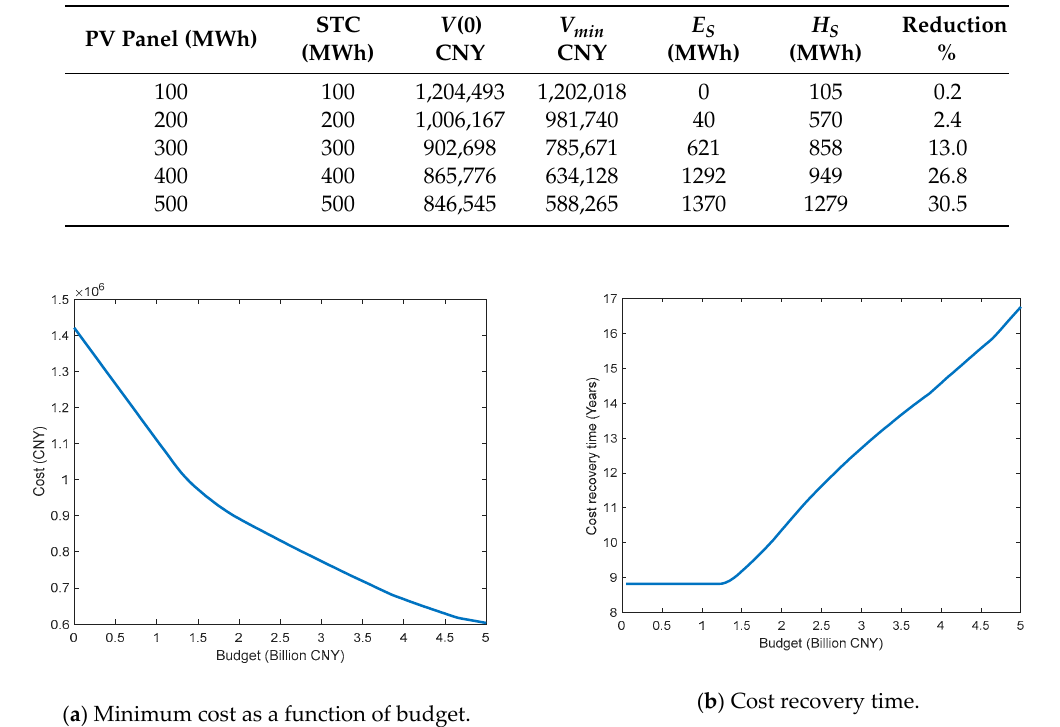
Table 2. Optimal storage sizes and economic performances with di ff erent solar capacities.